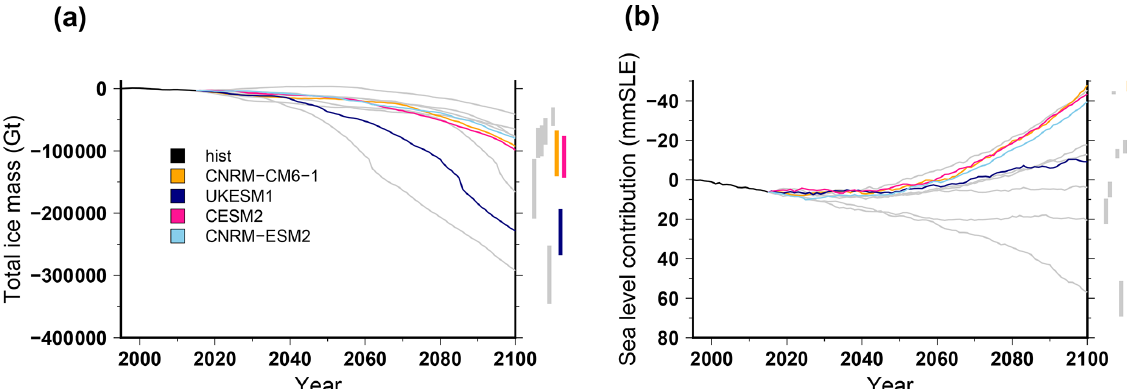
Figure 8. Simulated total ice mass change (a) and ice volume contributing to sea level rise (b) for projections under the different CMIP6 forcings using the SSP585 scenario and the medium oceanic sensitivity. The evolutions begin with the historical simulation hist (1995–2015). For each projection experiment the vertical bar shows the minimal and maximal changes associated with the oceanic-forcing sensitivity to temperature change ( low and high ). The grey lines are the changes under the CMIP5 forcings shown in Fig. 4.